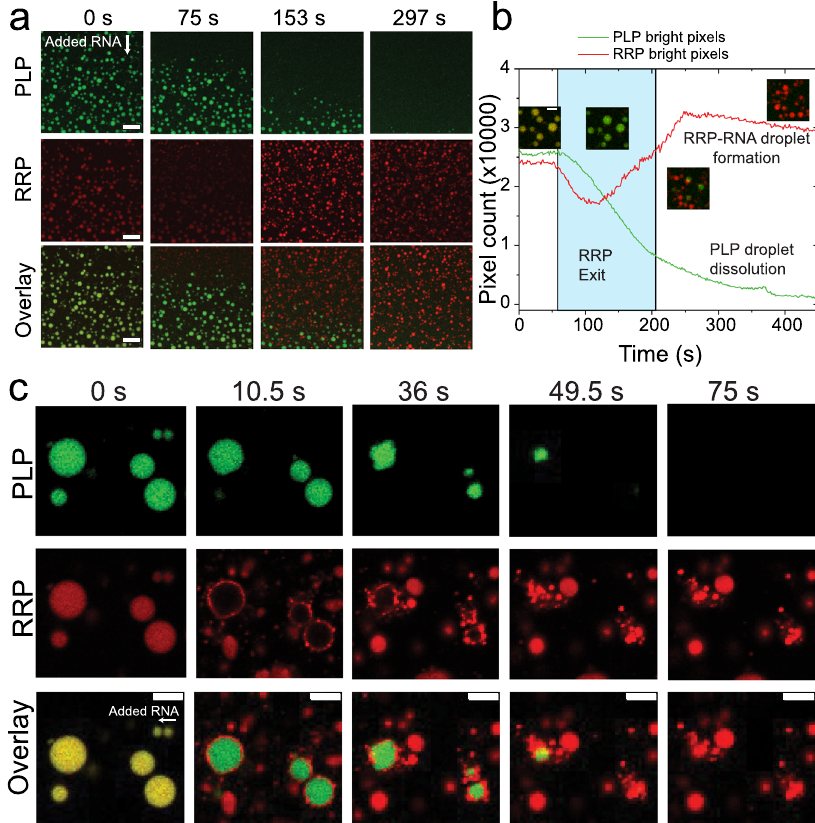
Fig. 2 RNA induces condensate switching from PLP-RRP to RRP-RNA. a Multicolor confocal fl uorescence time-lapse images showing dissolution of PLP- RRP (RRP: FUS RGG3 ) droplets and subsequent formation of RRP-RNA droplets upon addition of poly(rU) RNA. Scale bar = 20 µ m. b A plot of the total area covered by condensates in the green (PLP) and red (RRP) channels for the data shown in ( a ) and in Movie S1. The areas were calculated by counting the green pixels (for PLP) and the red pixels (for RRP) and plotted as a function of time. The images indicate the various stages of sample evolution after RNA addition. The white region (left) indicates the time-window where PLP and RRP co-localize; the cyan shaded region indicates the time-window when RRP is leaving the PLP-RRP condensates; the white region (right) indicates the subsequent dissolution of PLP-RRP condensates and the formation of RRP-RNA condensates. Source data are provided as a Source Data fi le. Scale bar represents 5 µ m. c Same assay as ( a ) but with poly(rA) RNA. (RRP: [RGRGG] 5